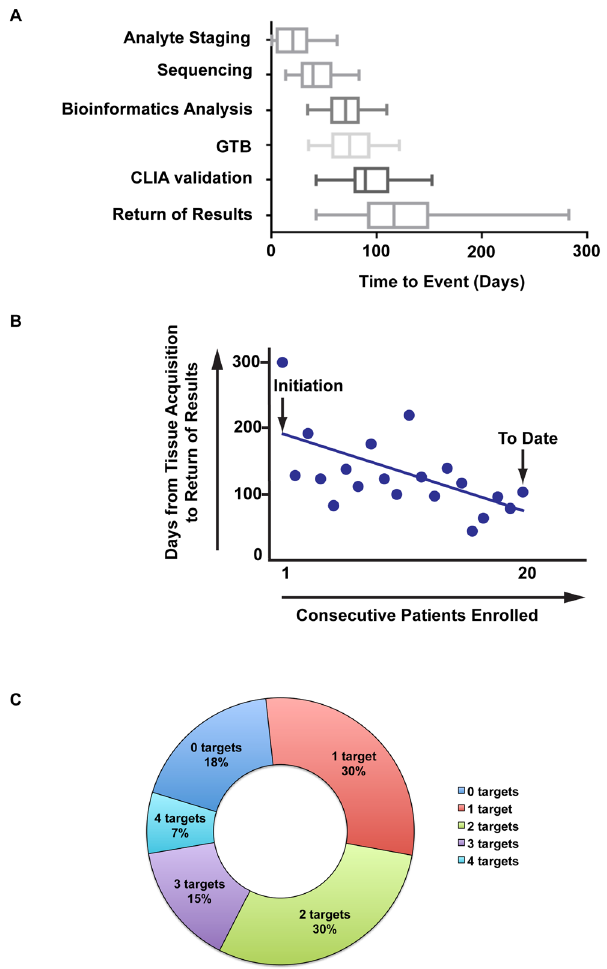
Figure 2. Time required from tissue acquisition to delivery of results to patient and actionable targets identified. ( A ) Range of time it takes to complete each portion of the WGS process. The boxes represent the 25–75th percentile and the line in the centre indicates the median. ( B ) Decrease in time for delivery of results to patient. ( C ) Summary of actionable targets identified per